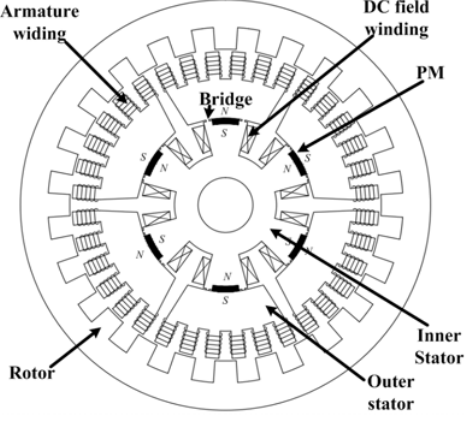
Figure 17. The hybrid-excitation stator-PM motor for the ISG system.